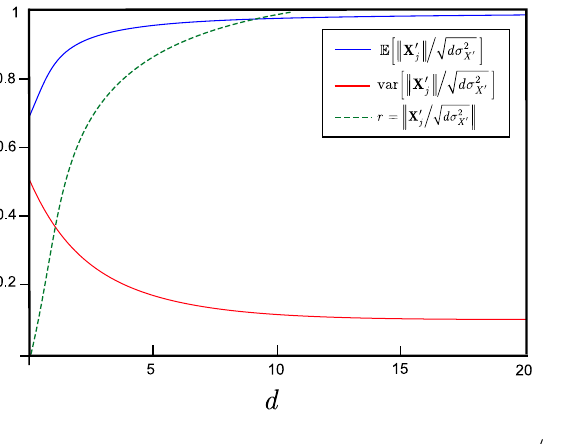
Figure 3. The mean é ù⋅ ë û  , variance var é ù⋅ ë û of the normalized quantity 2 j X d s ¢ ¢ X and the norm Figure 3. The mean E [ · ] , variance var [ · ] of the normalized quantity (cid:107) X (cid:48) j (cid:107) (cid:46)(cid:113) 2 d s ¢ ¢ X of the normalized Gaussian random vector 2 j X d s ¢ ¢ X . Vector j ¢ X is formulated (cid:107) X (cid:48) (cid:107) of the normalized Gaussian random vector X (cid:48) d σ 2 j X j X (cid:48) number of X (cid:48) j , i elements of Bob’s noisy raw data X (cid:48) . The approximation of the logical binary from d number of , j i X ¢ elements of Bob’s noisy raw data X ¢ . The approximation of the logical binary Gaussian gets more precise as the norm approaches to one, which requires the use of higher dimensions.